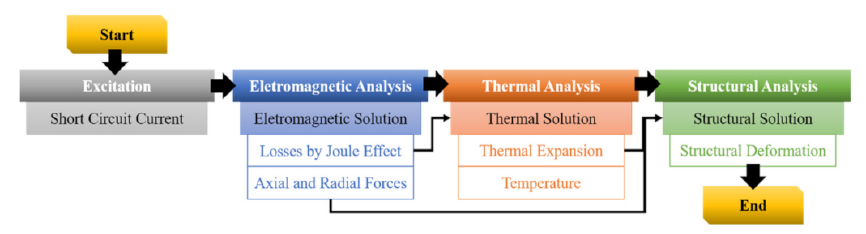
Figure 14. Magneto-thermo-structural coupling.